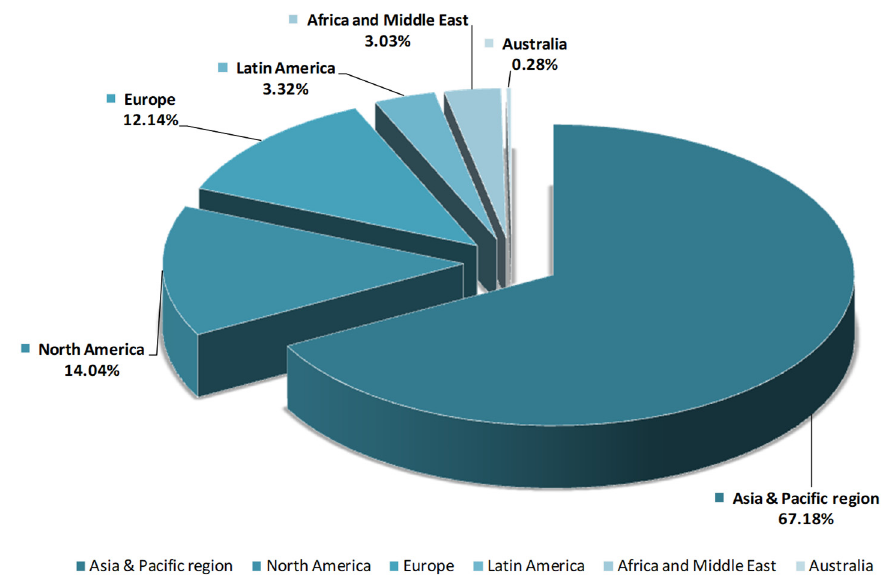
Figure 2. Hyaluronic acid market-regional comparison.